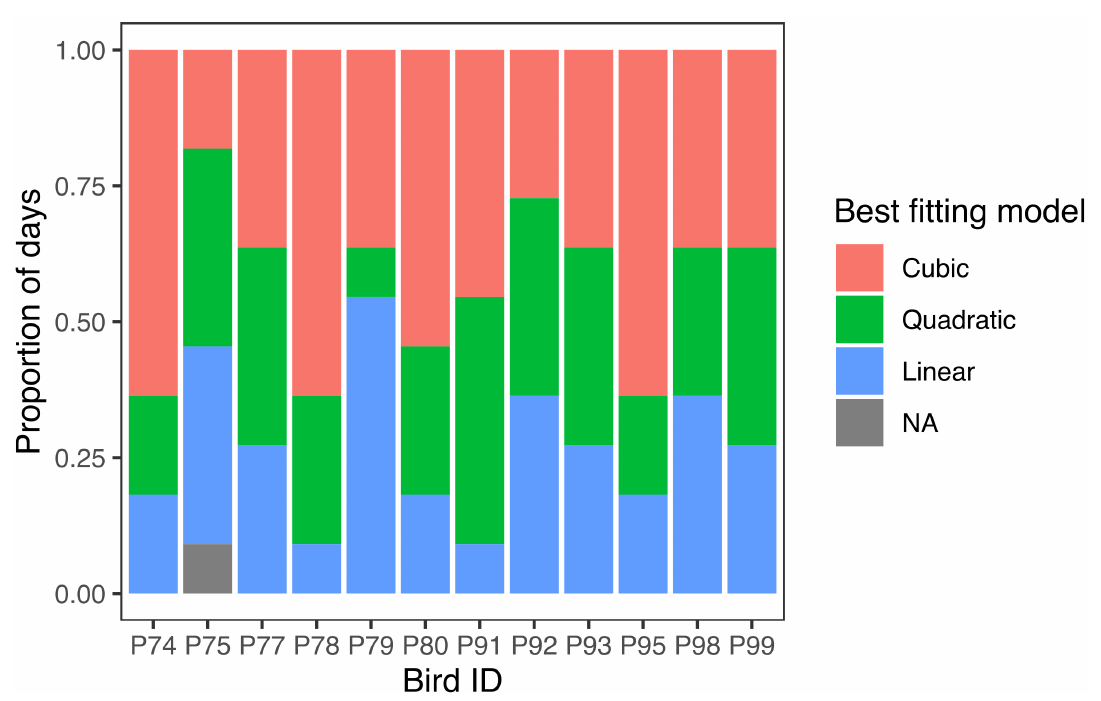
Figure 6. Best-fitting polynomial models describing the association between time of day and body mass. Stacked bar chart showing the proportion of days for each bird that were fitted best by a linear, quadratic, or cubic polynomial model. The ninth day of data for bird P75 was not fitted due to insufficient